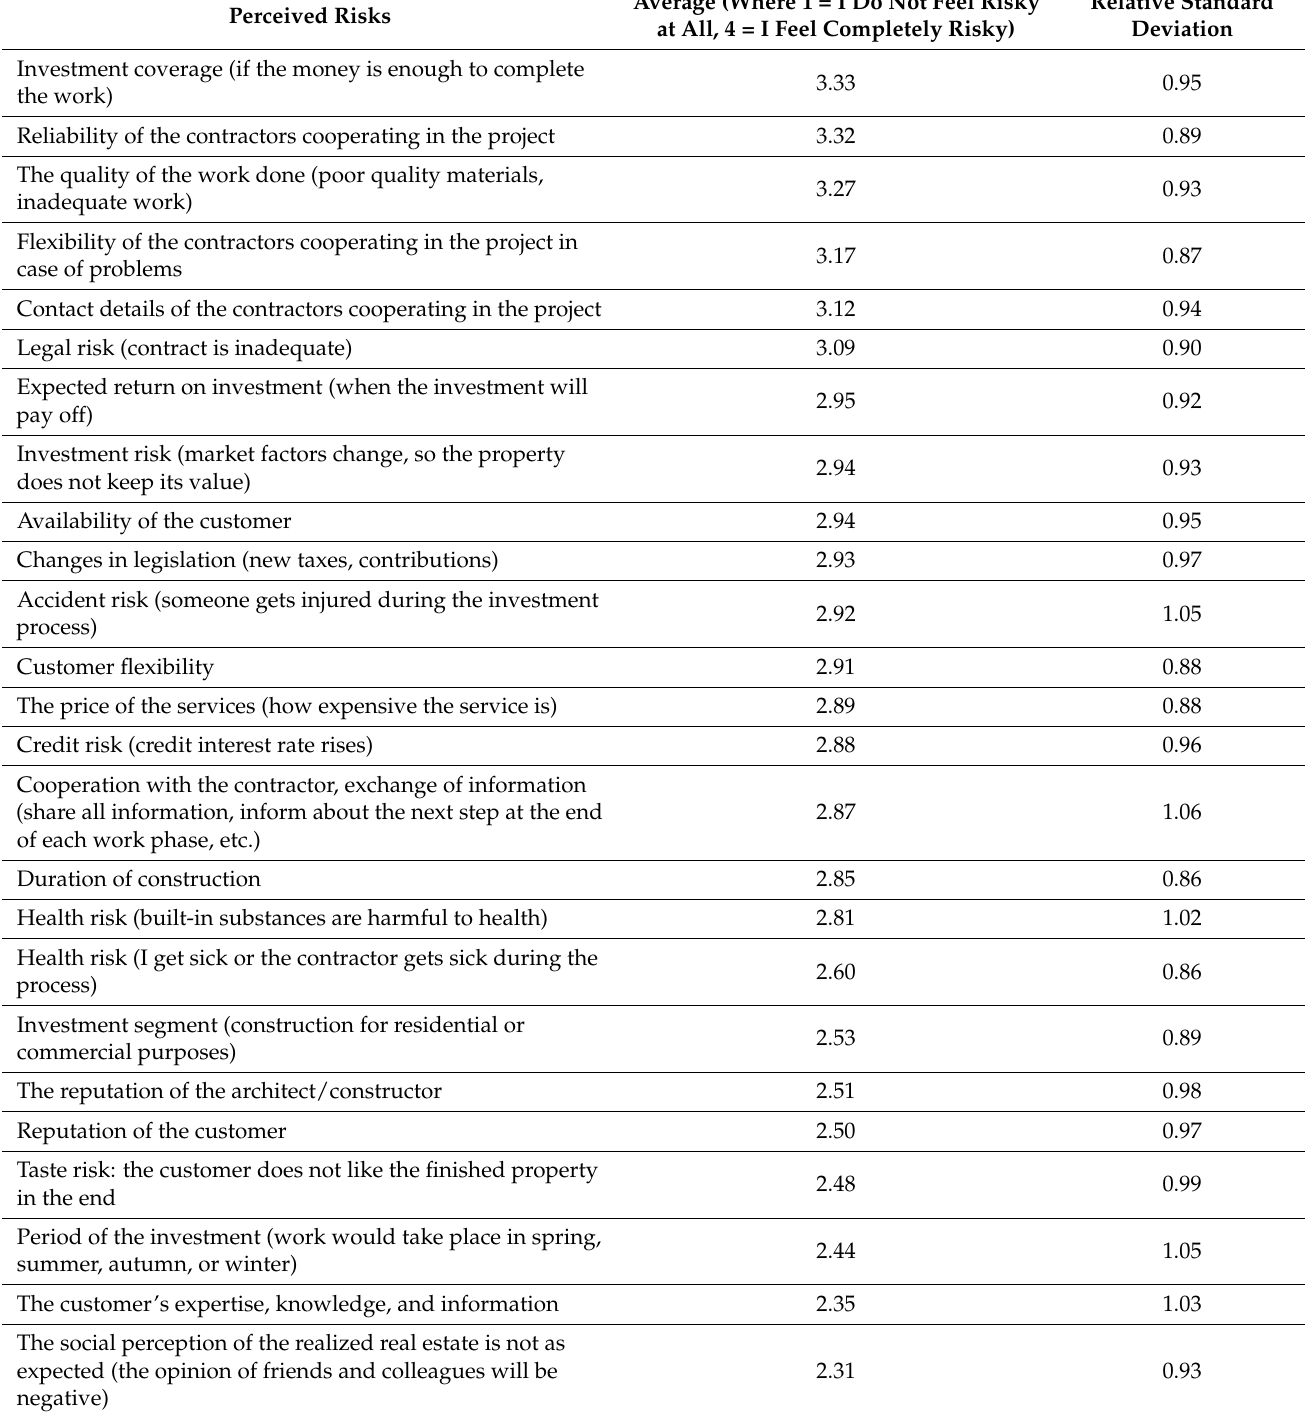
Table 5. Ranking of project risk factors detected by the contractor of the architectural investment (B2B, supply) side (mentions are in percentages). Source: authors’ own research, 2018, N = 462 persons (1–4 scale, where 1 = least important, 5 = most important); important factors: average ≥ 3; key factors: average ≥ 2; less important factors: mean < 2; (variance =